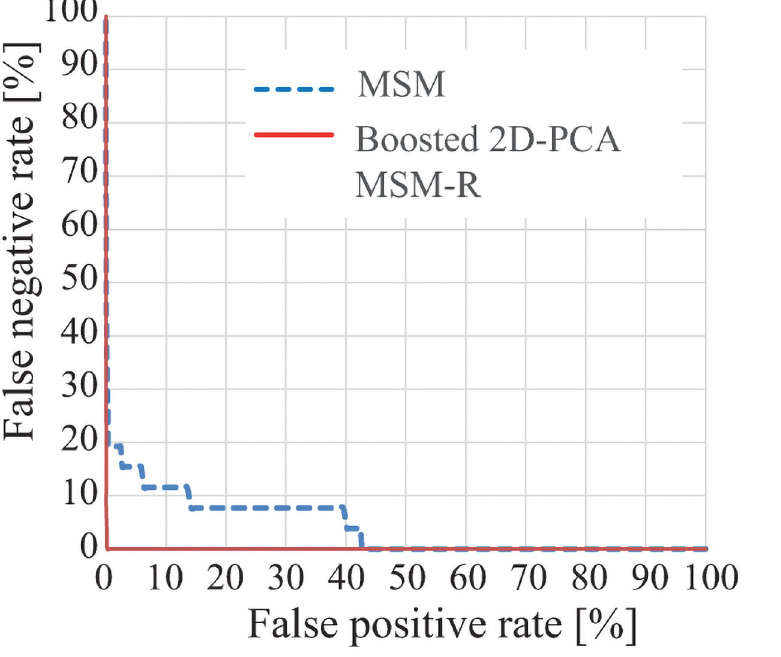
Fig 16. ROC curve by the B-2D-PCA-R MSM and the MSM-based method [11] for dataset 1.